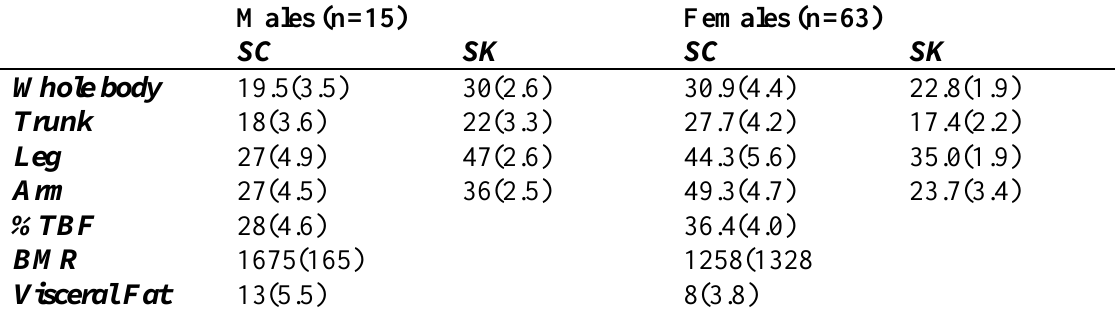
Table 3: Fat % and skeletal muscle% in different compartments of males and females